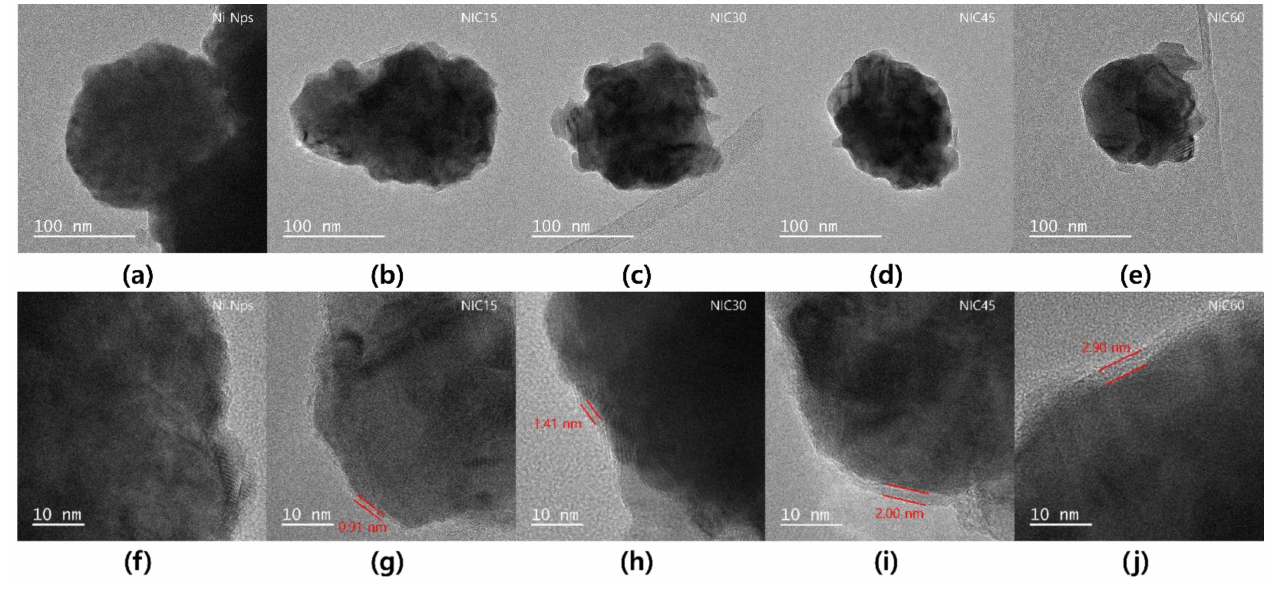
Figure 4. TEM images of ( a , f ) Ni Nps, ( b , g ) NIC15, ( c , h ) NIC30, ( d , i ) NIC45, and ( e , j )